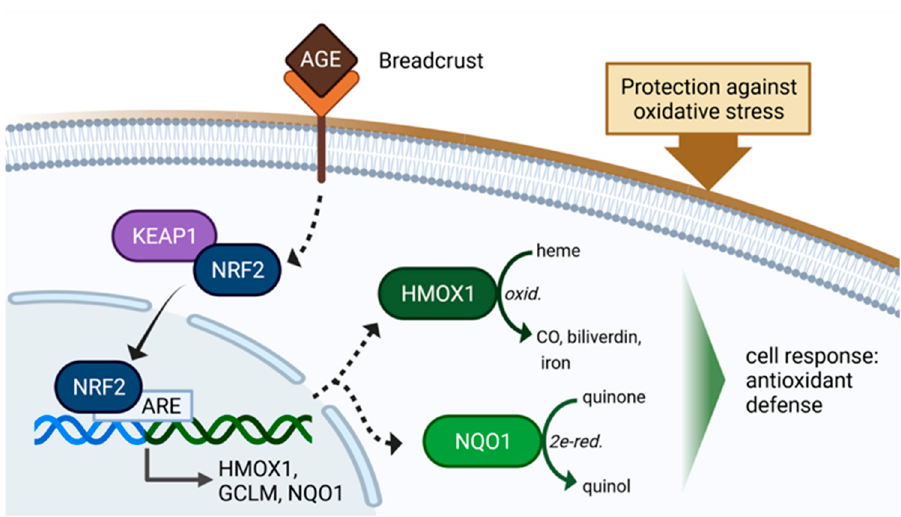
Figure 10. Model for the molecular mode of BCE action. The figure was created with BioRender.com.